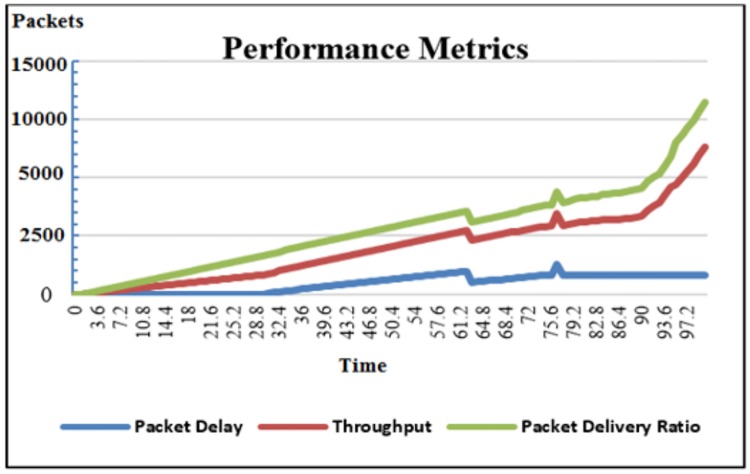
Performance metrics.